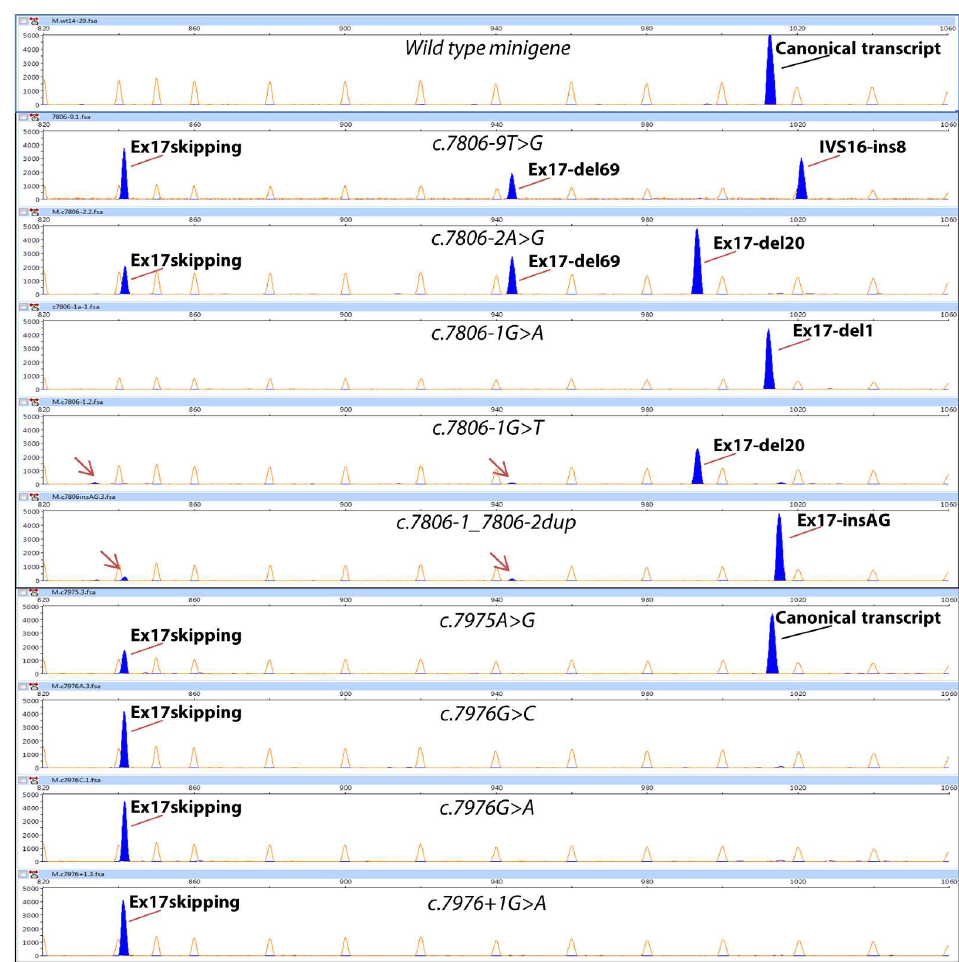
Fig 3. Analysis of transcripts induced by DNA variants from exon 17. cDNA was amplifiedwith primers RTBR2_ex16-FW ( BRCA2 exon 16) (blue peaks) and FAM-labelled RTpSAD-RV (vector exon V2) and electrophoresed on a DNA sequencerwith Genescan LIZ 1200as size standard (orange/faint peaks). Arrows indicate minor aberranttranscripts. Screenshots of electropherogramsvisualizedwith the Peak Scanner software v1.0 are shown. Fragment sizes (bp) and relativefluorescent units are indicatedon the x- and y-axes, respectively.